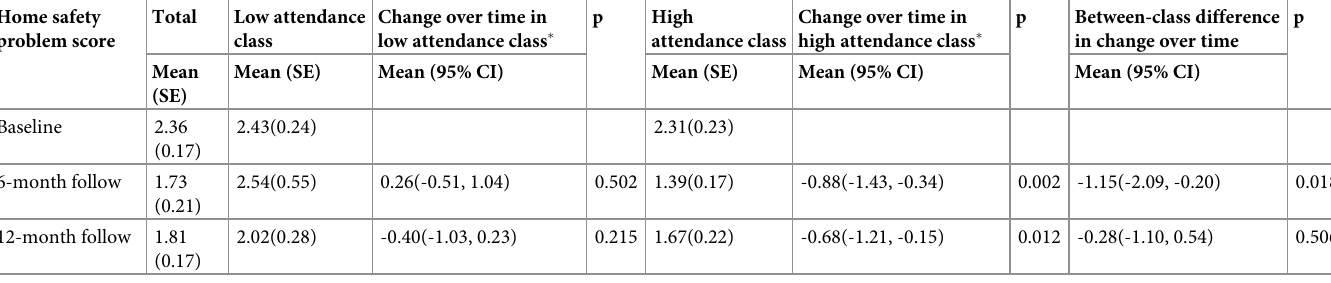
Table 3. Linear mixed model on home safety problem score in relation to latent class